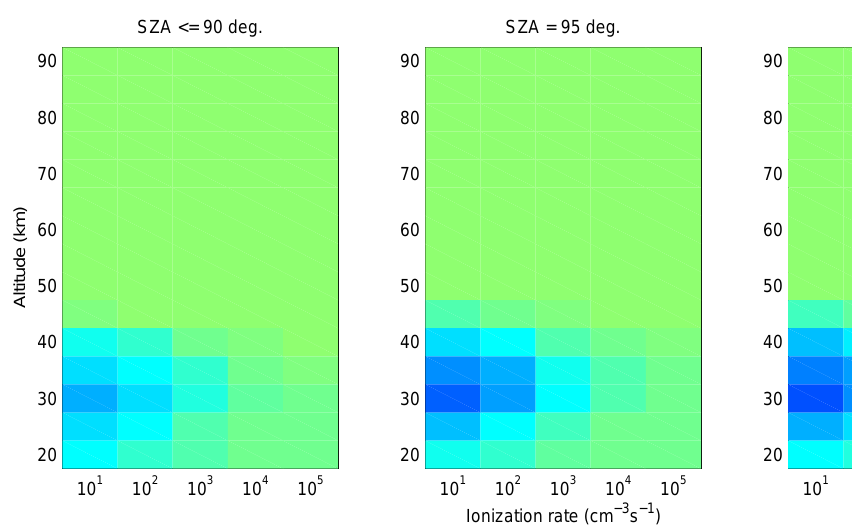
/Q for October 2 O 5